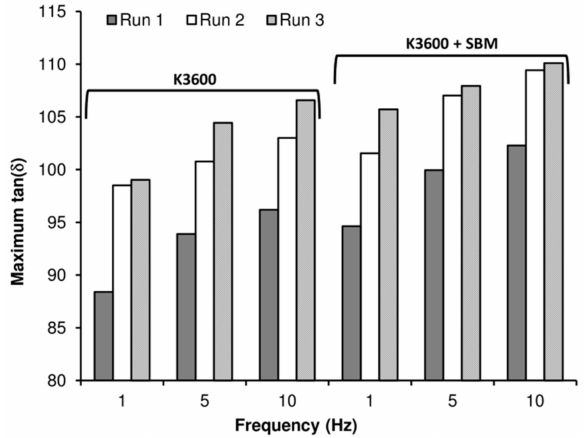
Figure 6. Peak tan( δ ) response as a function of applied frequency and number of runs for the neat and SBM-toughened K3600 resin coupons analysed via